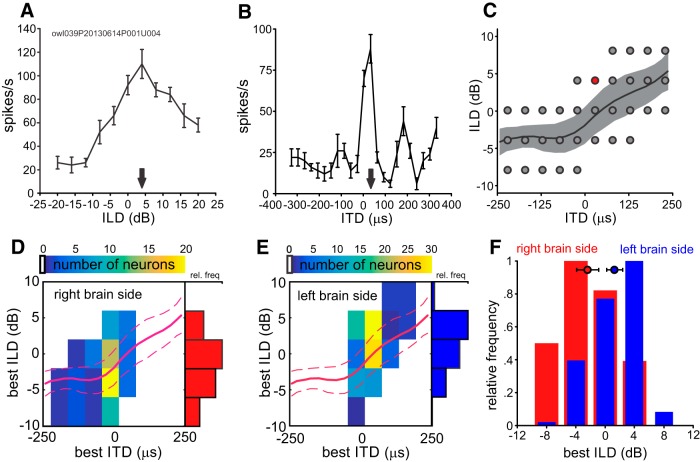
Representation of azimuthal ITD and ILD in the external nucleus of the inferior colliculus (ICX). A, Typical ILD tuning curve as measured in left ICX. Response rate is plotted as a function of ILD. The ILD that evokes the highest response rate (best ILD, +4 dB) is shown with a black arrow. B, ITD tuning curve of the same neuron as in A. Response rate is plotted as a function of ITD. Black arrow indicates best ITD (+30 μs). C, Indicated by the black line are the ILD/ITD combinations occurring on the equatorial plane. Shaded area shows SD of ILD. The circles indicate the best ITD/best ILD pairs from the total population of recorded ICX neurons considered in the following analysis. Each circle depicts the center of a histogram bin, which includes all best ITD/ILD of corresponding values. The value for the neuron in A, B is shown as a red filled circle. D, E, Distributions of best ITDs and best ILDs in the left and right ICX. Red line shows the ITDs and ILDs occurring on the equatorial plane as in C. Placed underneath are the histogram data of best ILDs and ITDs (from electrophysiological recordings). The color code shows the number of units with preferred ITD/ILD pairs in a histogram bin. Bin width for ILD is 4 dB, and 60 μs for ITD. More negative ILDs were found in the right hemisphere, while more positive ILDs were found in the left ICX. Data basis: 395 single neurons or multi-units from ICX. Distribution is shown for those neurons that match the dots in C (left: n = 76, right: n = 109). F, Distribution of best ILDs in the ICX in the left (blue) and right (red) brain side summarizing data from D, E. Color filled circle indicate mean best ILD for left (blue) and right (red) brain side. Error bars show 99.9% confidence intervals. Negative ITD and ILD values refer to left ear earlier or left ear louder.